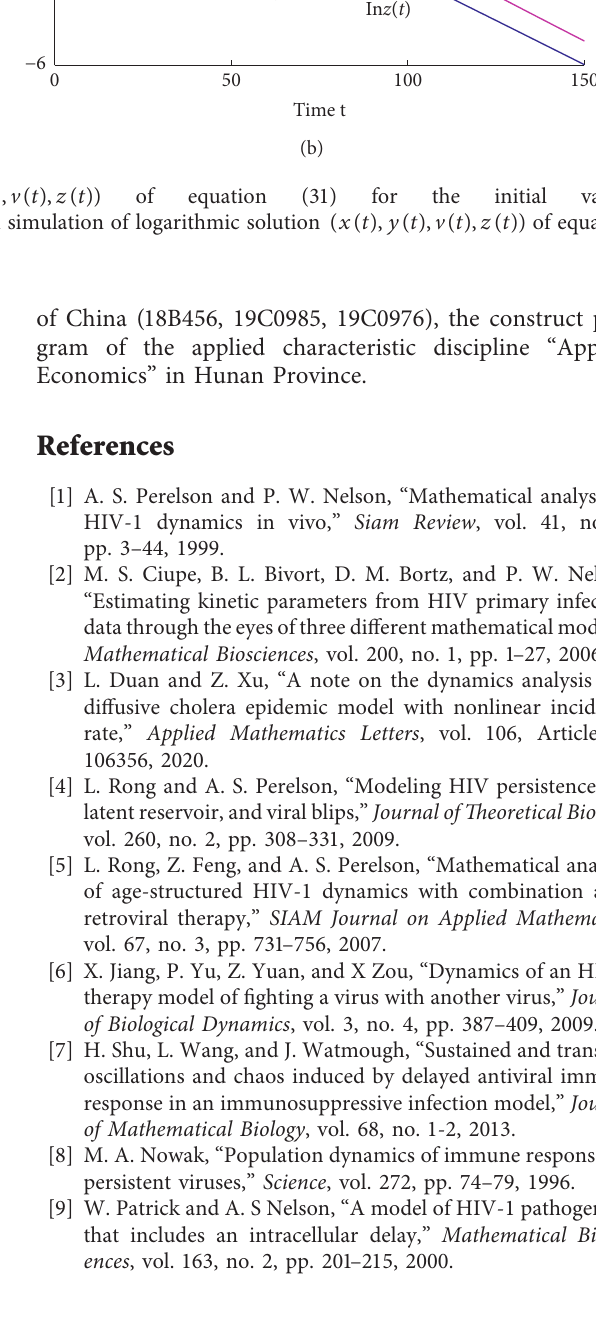
The numerical solution ( x ( t ) , y ( t ) ,v ( t ) , z ( t )) of equation (31) for the initial values ,y ( 0 ) � 40 ,v , z ( 0 ) � 20 ,s ∈ [− 1 , 0 ] ; (b) the numerical simulation of logarithmic solution ( x ( t ) ,y ( t ) , v ( t ) , z ( t )) of equation x s ≡ 60 s ≡ 30